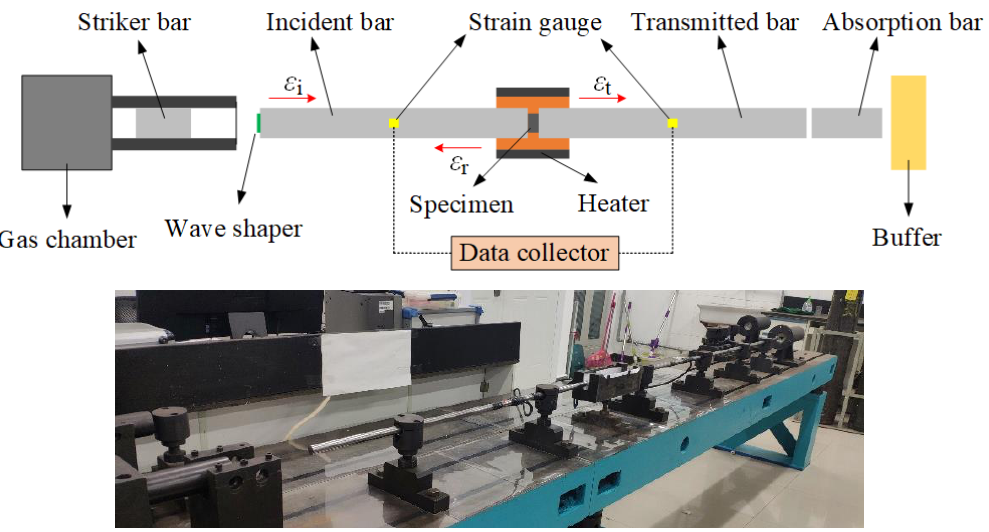
Figure 3. The SHPB system.